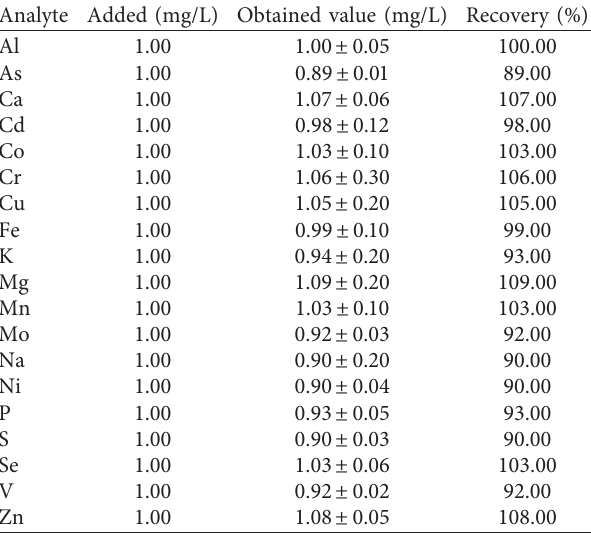
Table 4: Addition and recovery tests ( n �